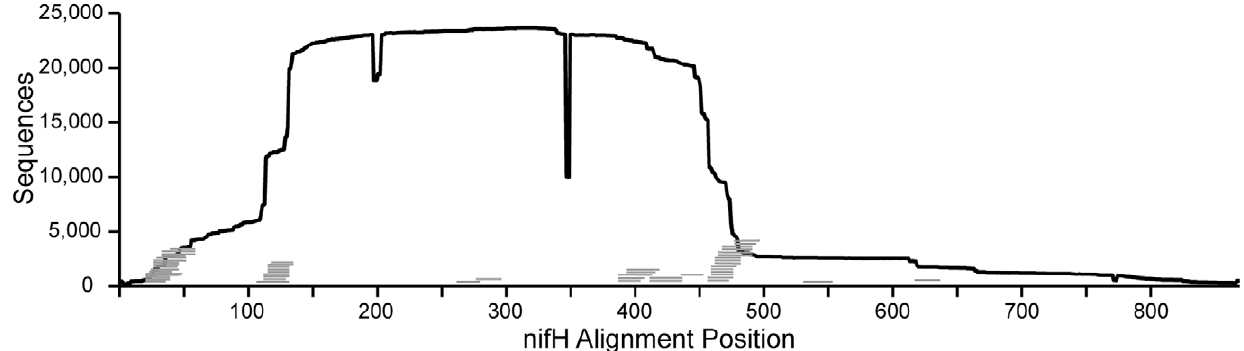
Figure 1. Coverage of the nifH gene by sequences and primers in the nifH database. The number of sequences in the nifH database is depicted in relation to alignment position along the gene. Alignment positions are referenced to the nifH nucleotide position from Azotobacter vinelandii (Genbank ACCN # M20568). Universal nifH primer sequences listed in Table 1 and 2 are indicated by grey horizontal lines.